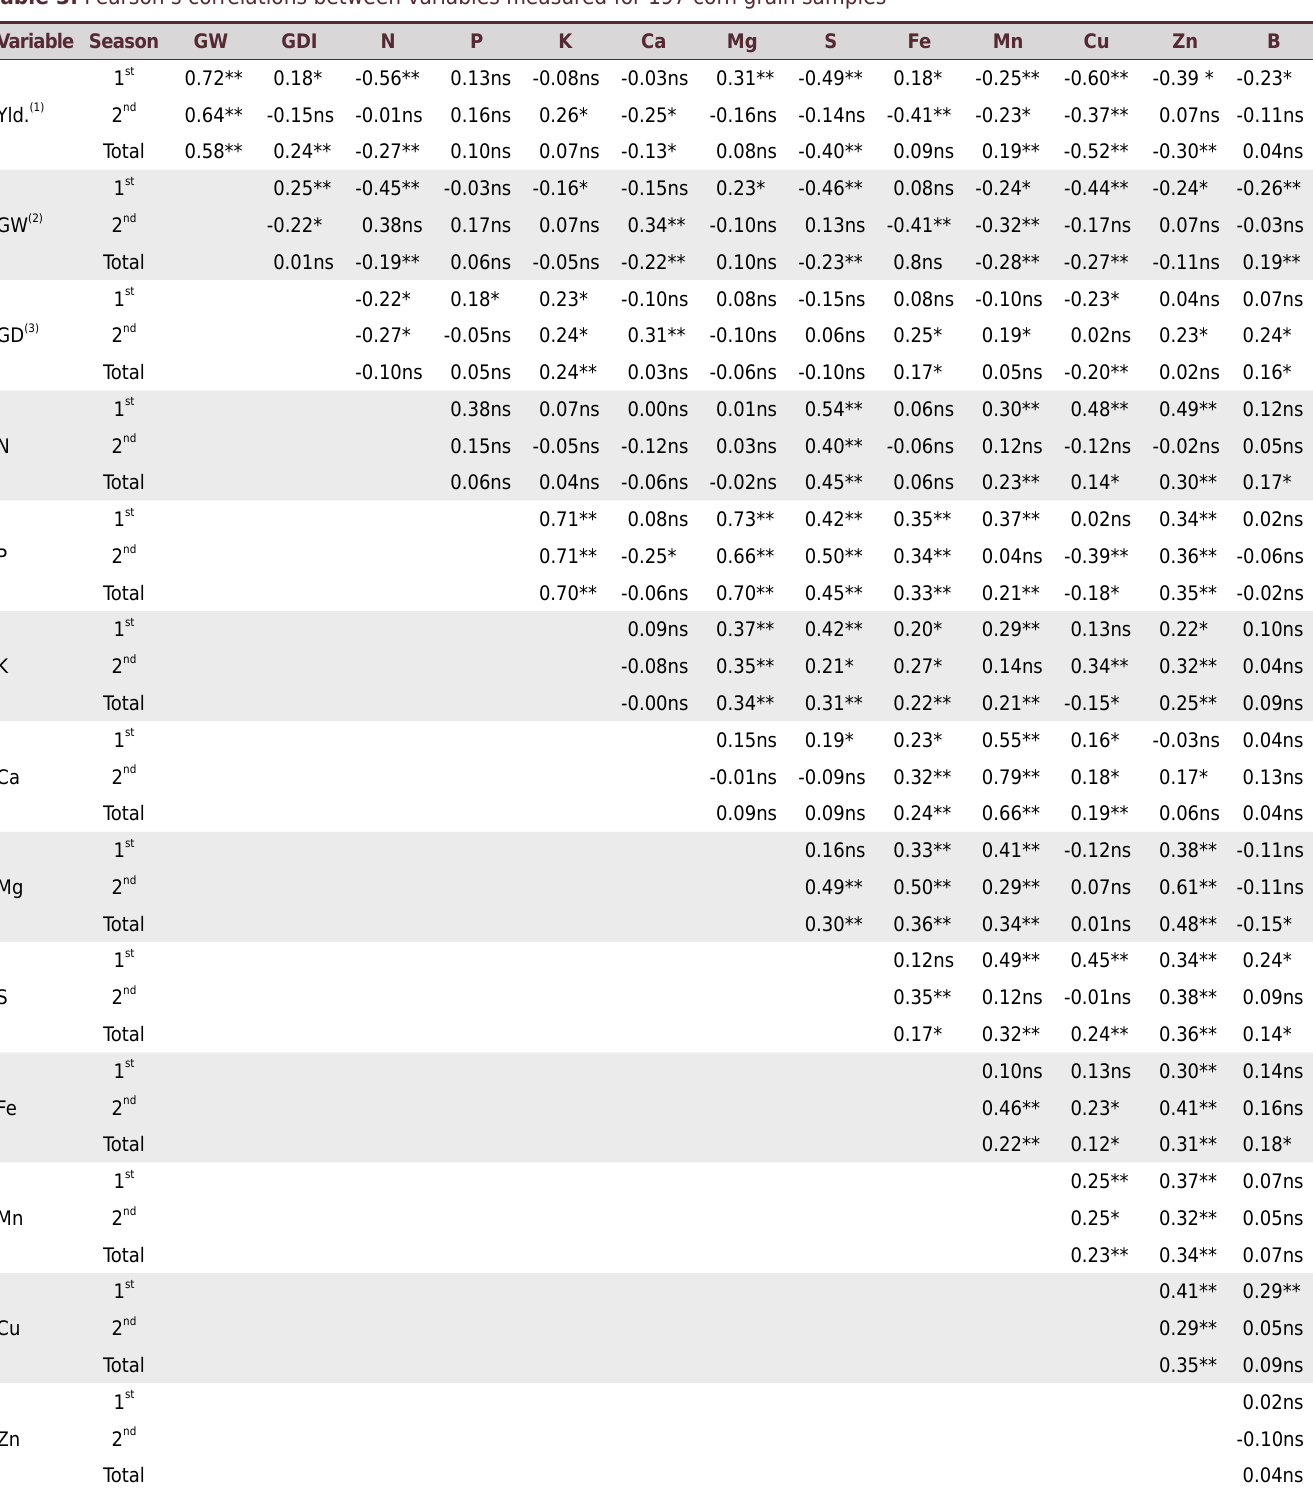
Table 3. Pearson’s correlations between variables measured for 197 corn grain samples Variable